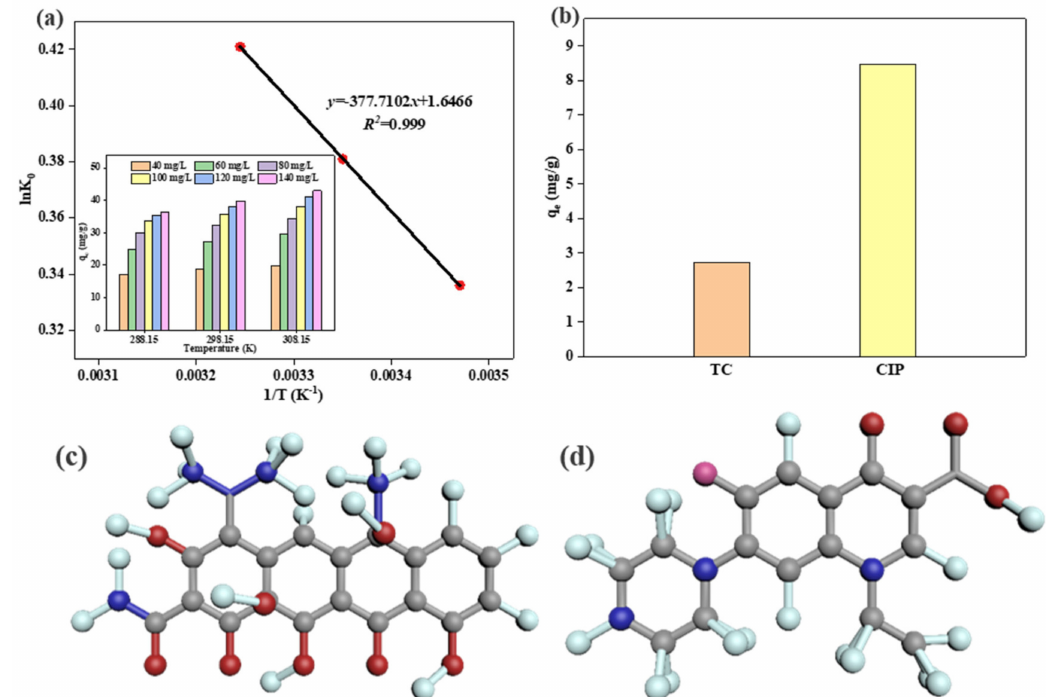
Figure 7. ( a ) The fitting plot of thermodynamic model, ( b ) Adsorption capacity of CA-Al-KABs to tetracycline and norfloxacin (pH: 4, contact time: 1440 min, m / v: 0.04 g / 50 mL), ( c ) Tetracycline structure, ( d ) Norfloxacin